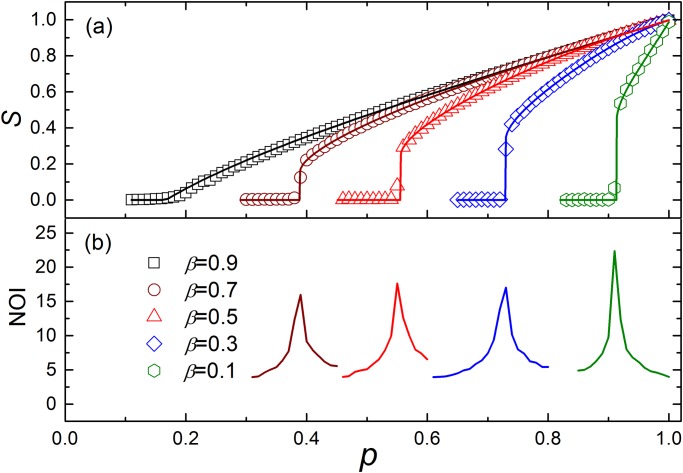
The simulation results of ER networks with 20000 nodes for different β.In the simulation, the parameters are set as: ⟨k⟩ = 6, g = 5. (a) The size of the giant component S versus p, the fraction of nodes that have been left after random removal. The symbols represent simulation results, and the solid lines show the corresponding analytical predictions of Eq (9). For β > (g − 1)/g, the dependence group has no effect on the cascading process, then the percolation process leads to a second order phase transition. When β < (g − 1)/g, a first order phase transition can be found. Both the first and the second order phase transition processes obey Eq (9). (b) As pointed in ref.[10], the number of iterative failures (NOI) sharply increases when p approaches the critical point, so the sharp peaks can identify the corresponding critical points pcI for the first order transition region.